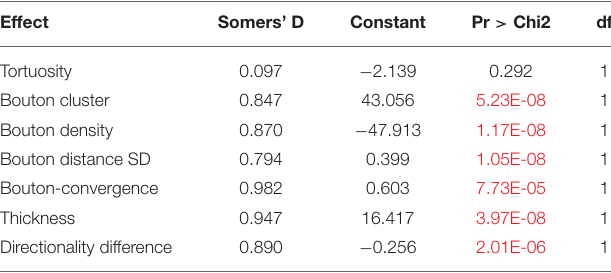
The values showing significant fit are highlighted in red.